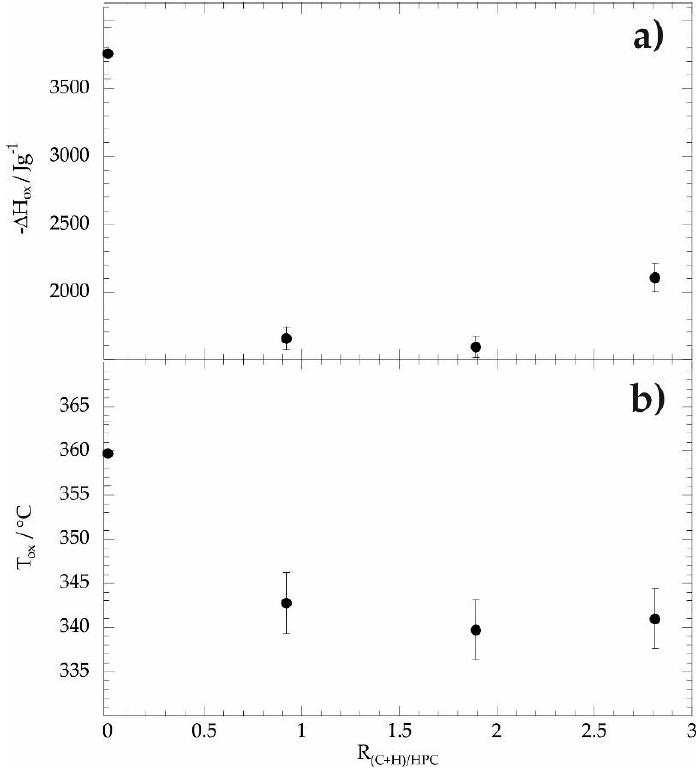
Figure 6. The enthalpy variation ( a ) and temperature ( b ) of oxidative degradation as functions of the weight ratio between the middle layer (chitosan + HNTs) and outer layers (HPC).